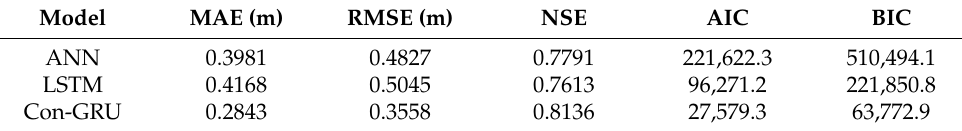
Table 3. Average indicators values of three models from 100 samples.